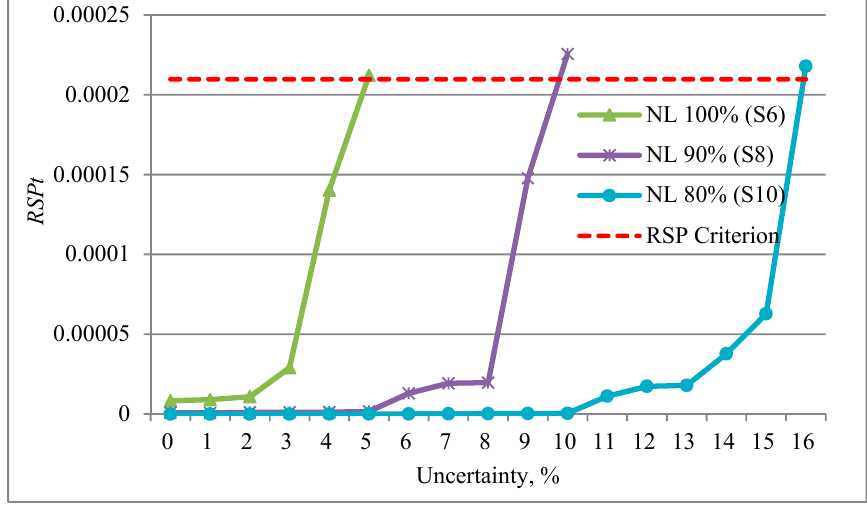
Figure 9. Results of sensitivity analysis for increased variability: enlarged graph for S7, S9, and RSP criterion.